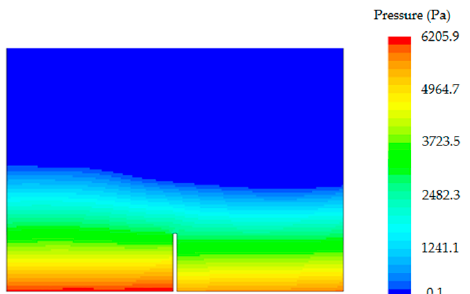
Figure 32. Pressure distribution in the STAR-CCM+ simulation with the baffle.